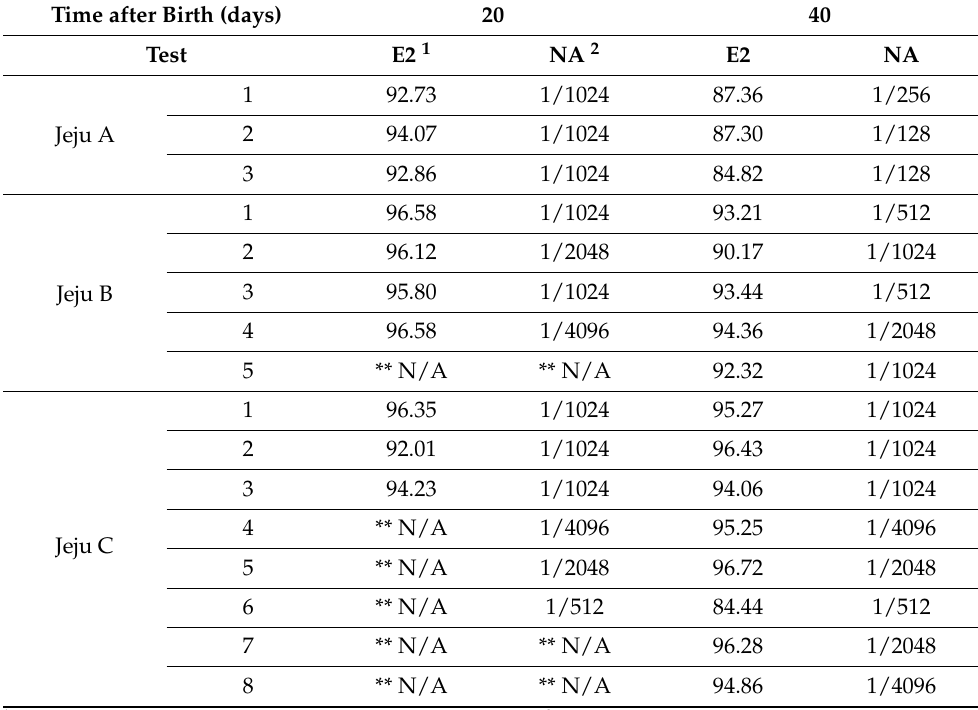
Table 2. Serological analysis of serum samples from newborn piglets on farms on Jeju Island. Time after Birth